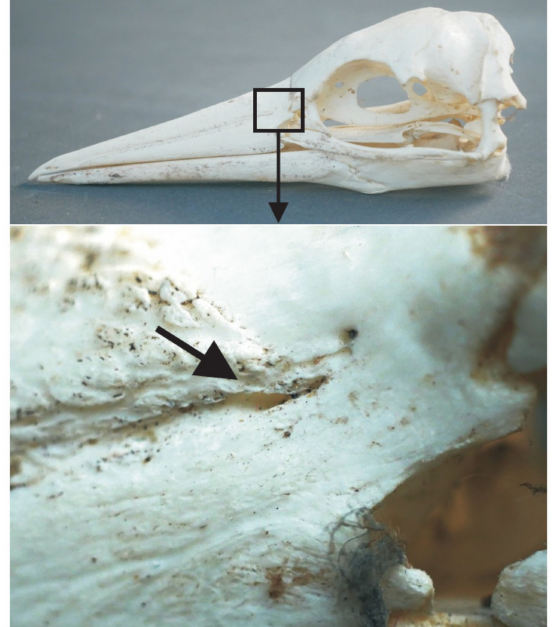
Figure 12. Australasian gannet, Morus serrator . skull with site of closed external naris